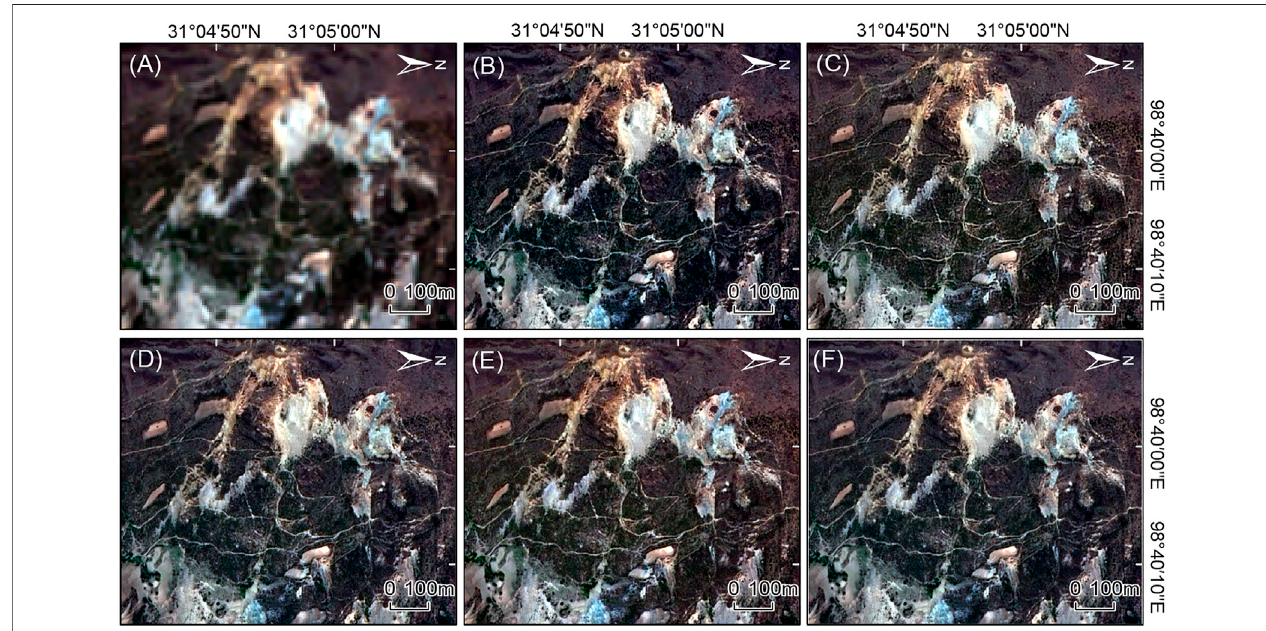
FIGURE4| Visualeffectsofdifferentfusionmethods (A) MSimage (B) Pansharpeningfusedimage (C) HPFfusedimage (D) GSfusedimage (E) PCAfusedimage (F) NND fused image.